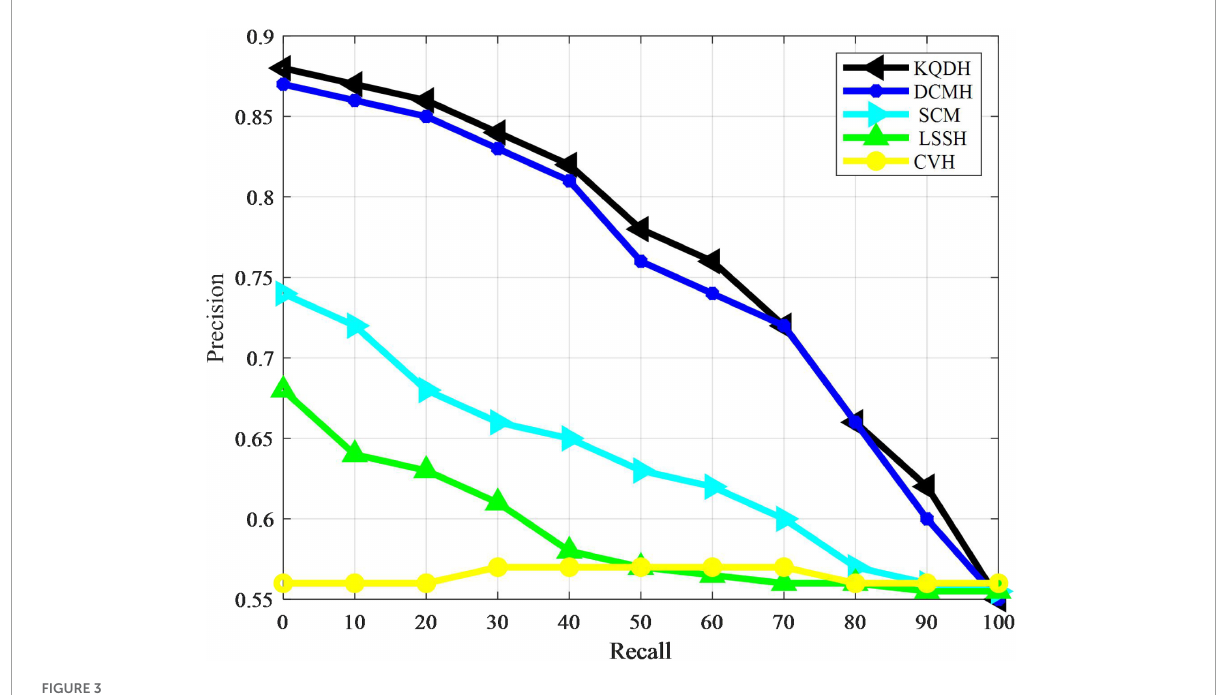
FIGURE3 Accuracy recall rate curve of MIRFLICKR-50K data set.